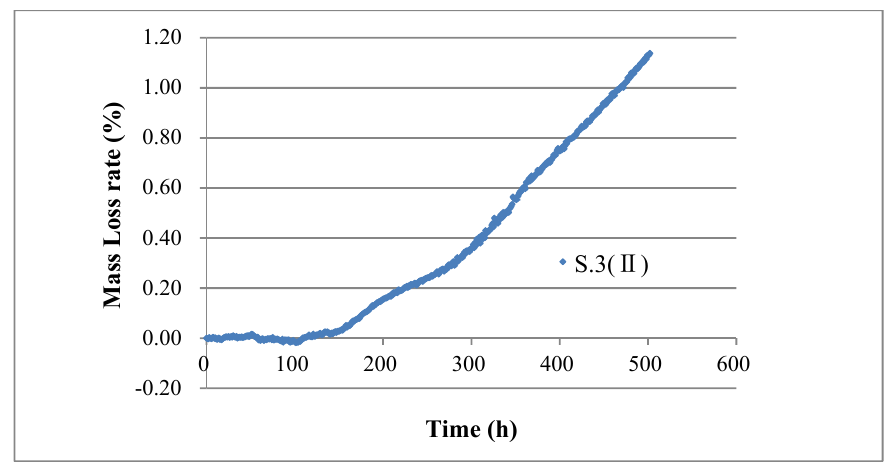
Figure 26. Mass loss rate results of S.3